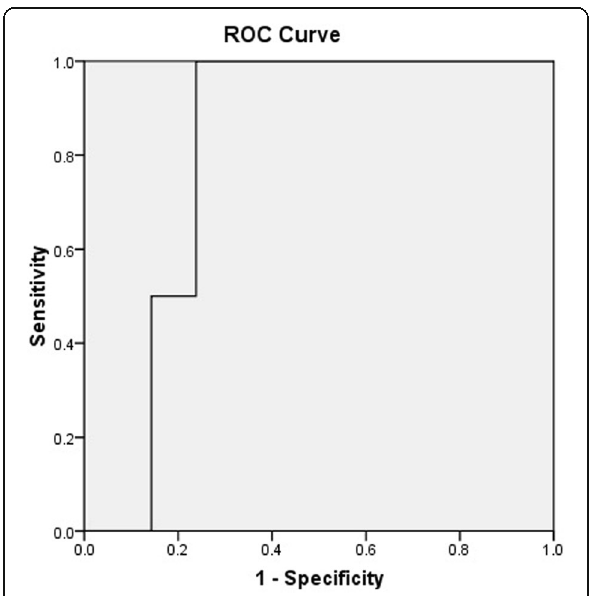
Fig. 8 Receiver operating characteristic (ROC) curve for detection of sensitivity and specificity of Delta MPV at day